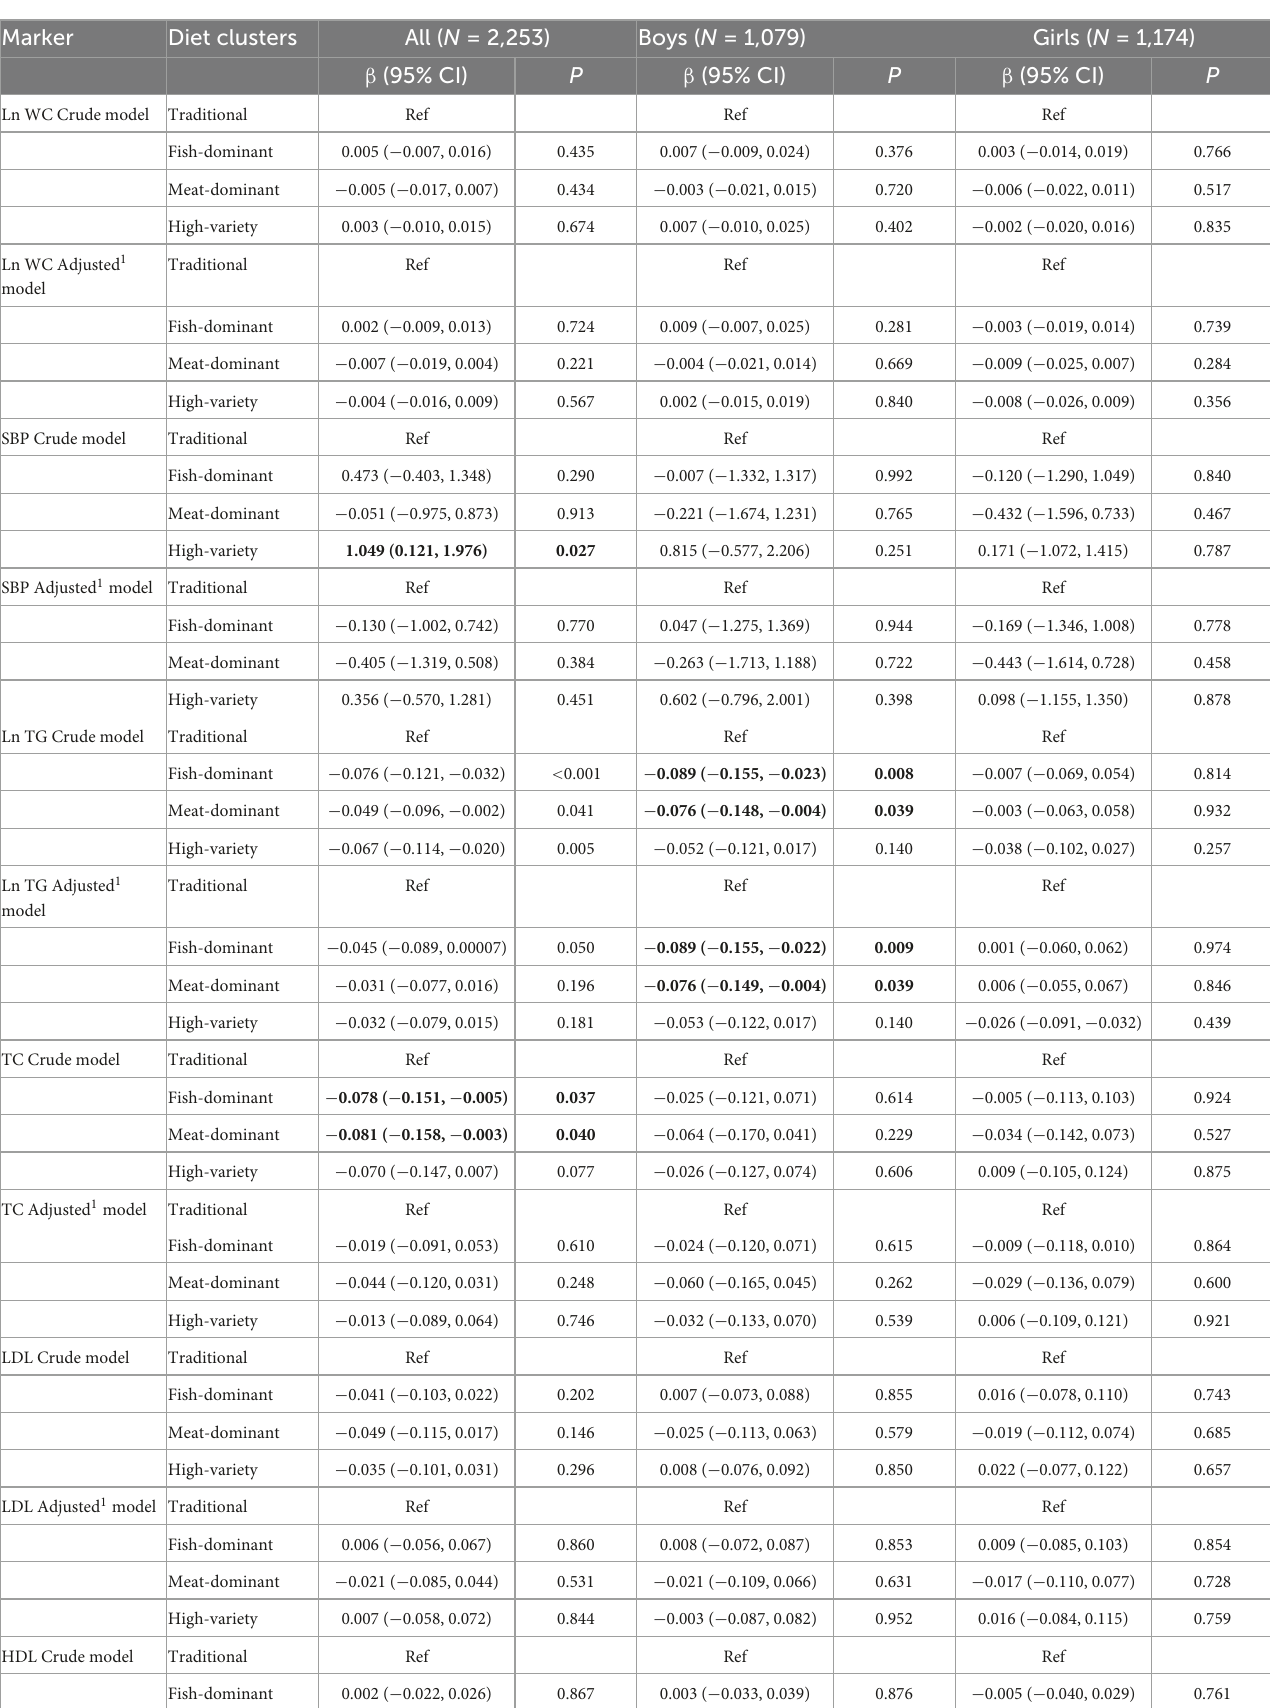
TABLE 4 Overall and gender-stratified associations of diet clusters with anthropometric and blood markers of cardiometabolic risk among the Maternal and Infant Nutrition Intervention in Matlab (MINIMat) adolescents. Marker Diet